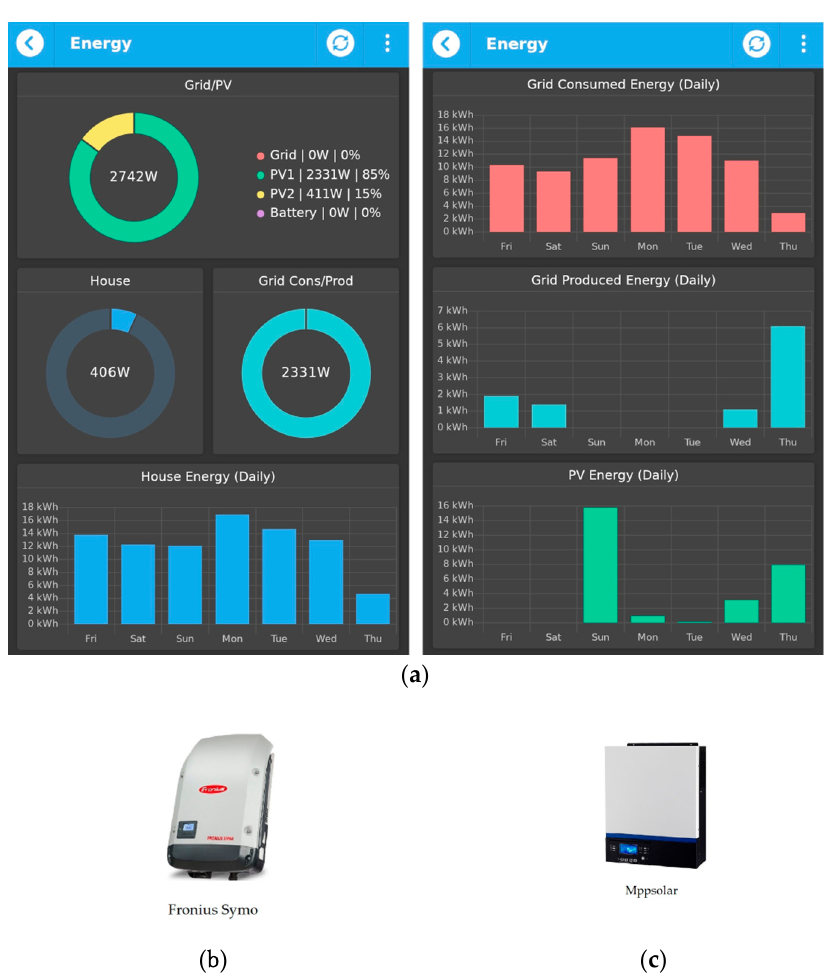
Figure 10. Monitoring the energy with qToggle ( a ) and the two invertors: Fronius Symo ( b ) and Mppsolar ( c ).